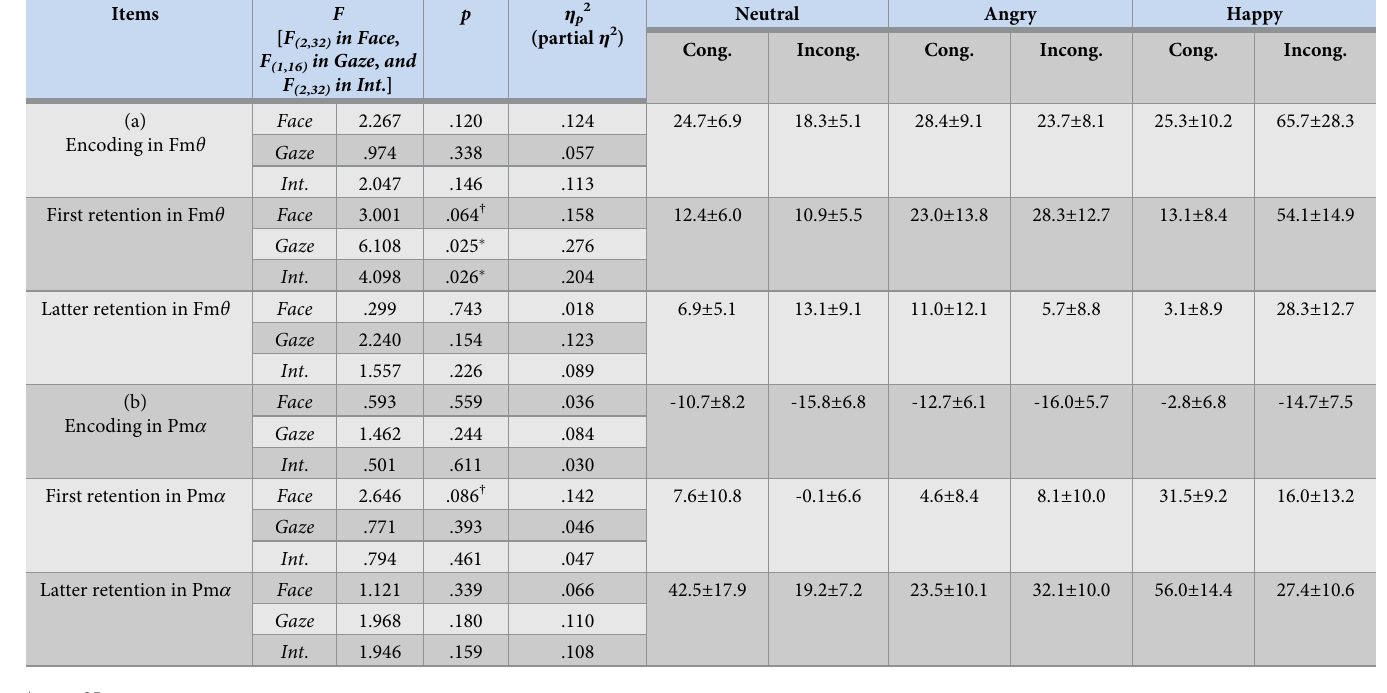
Table 5. Statistics for the induced θ and α powers at Fz and Pz sites during the working memory task for young adults. Items F Neutral Angry Happy p η p 2 [ F , (partial η 2 ) (2 , 32) in Face Cong. Incong. Cong. Incong. Cong. Incong. F (1 , 16) in Gaze , and F (2 , 32) in Int .]